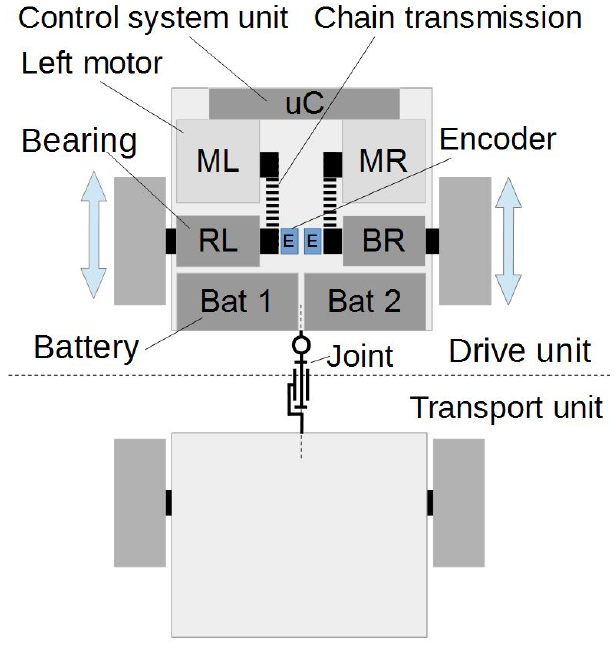
Figure 1. Mobile platform.